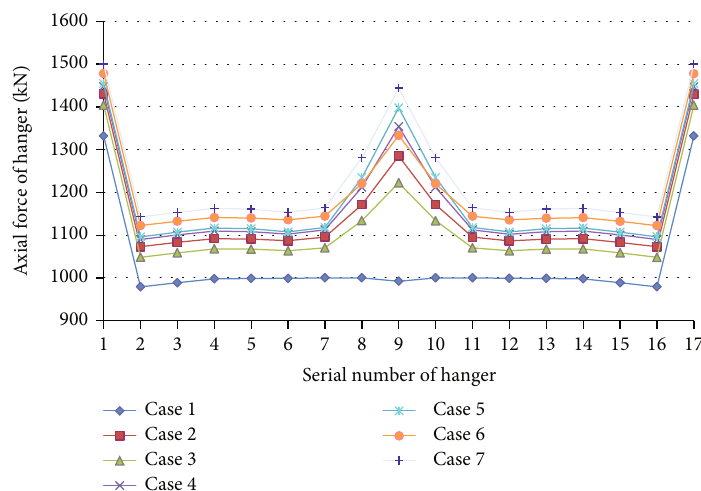
Figure 10: The variation curve of hanger axial force on the north side of arch bridge under various cases.